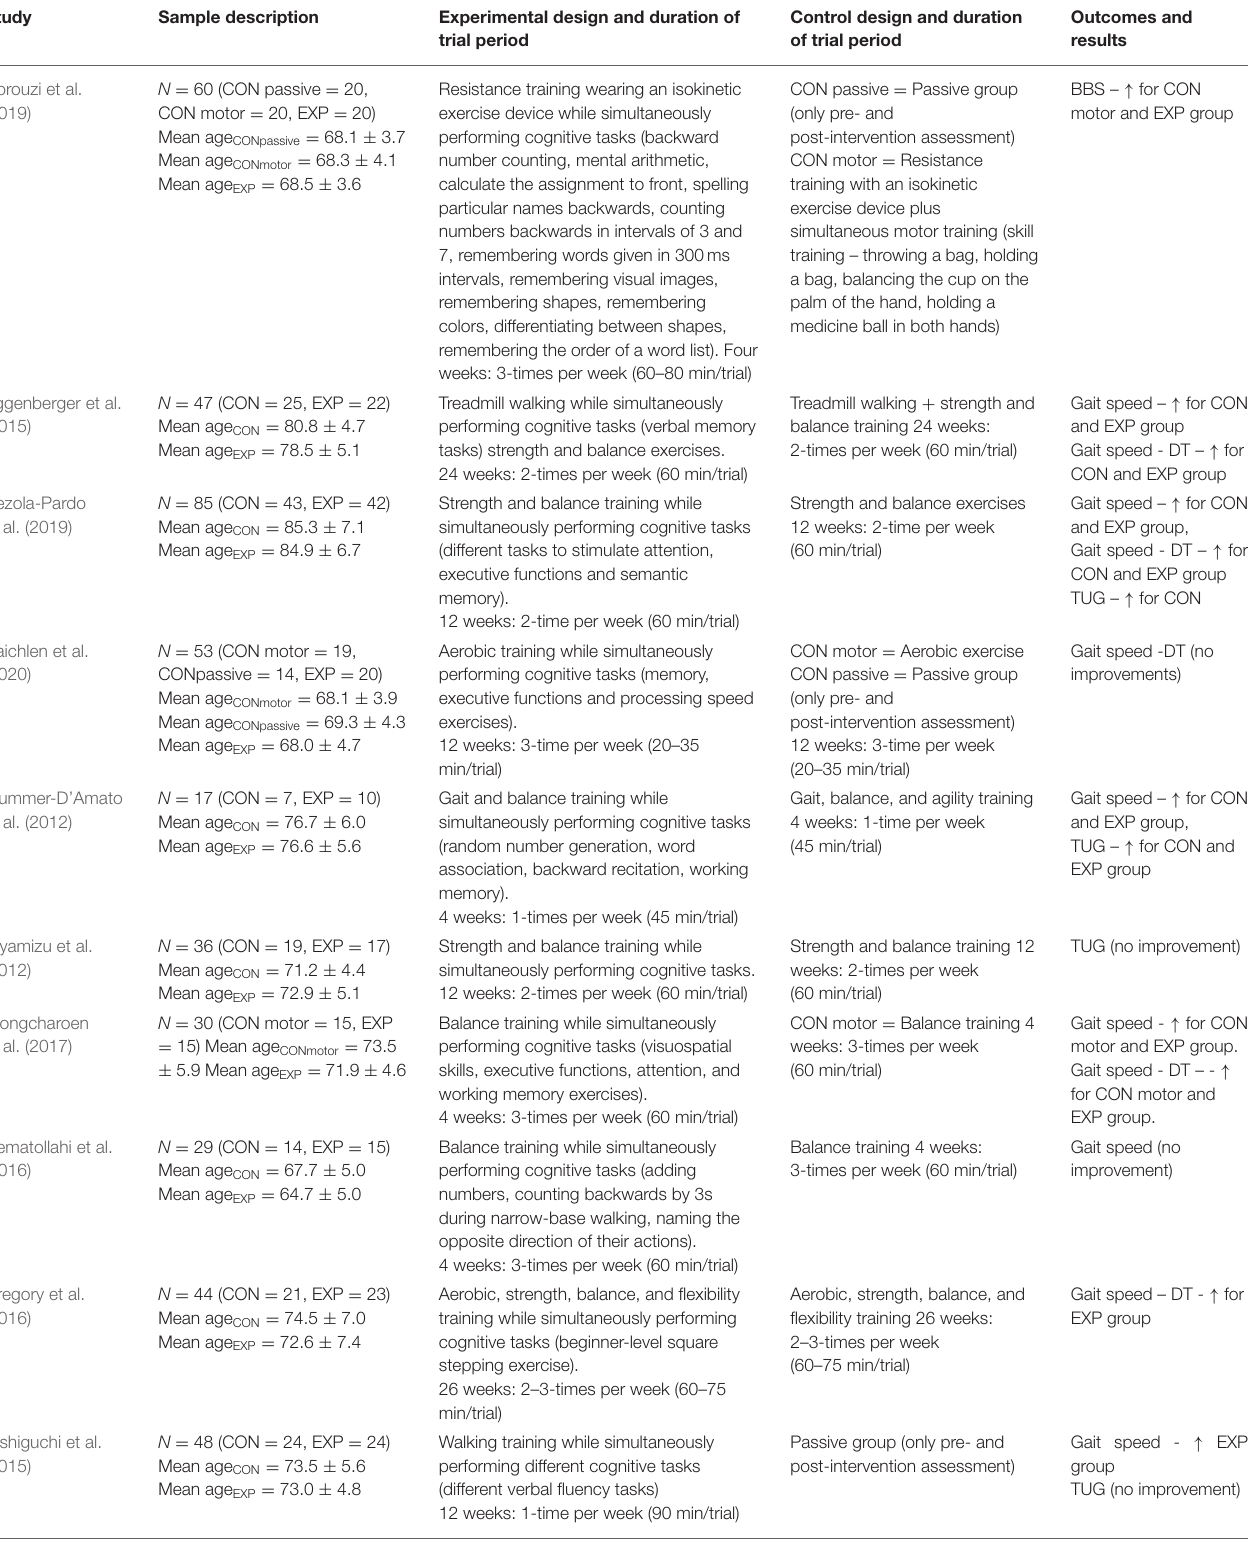
TABLE 4 | Simultaneous motor-cognitive training with additional cognitive